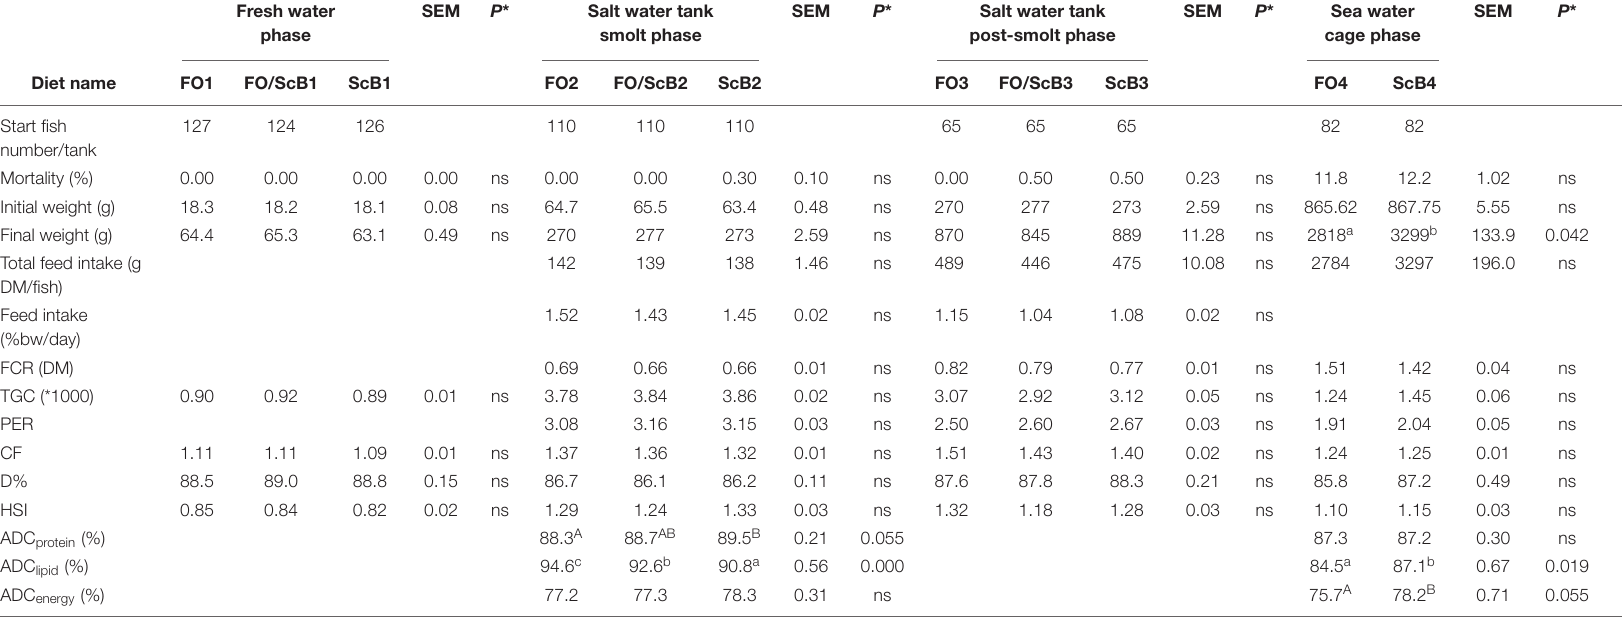
TABLE 2 | Growth, feeding performance, and biometrics of all Atlantic salmon individuals participating each one of the successive trials, fed diets with different levels of fish oil (FO), and Schizochytrium limacinum biomass